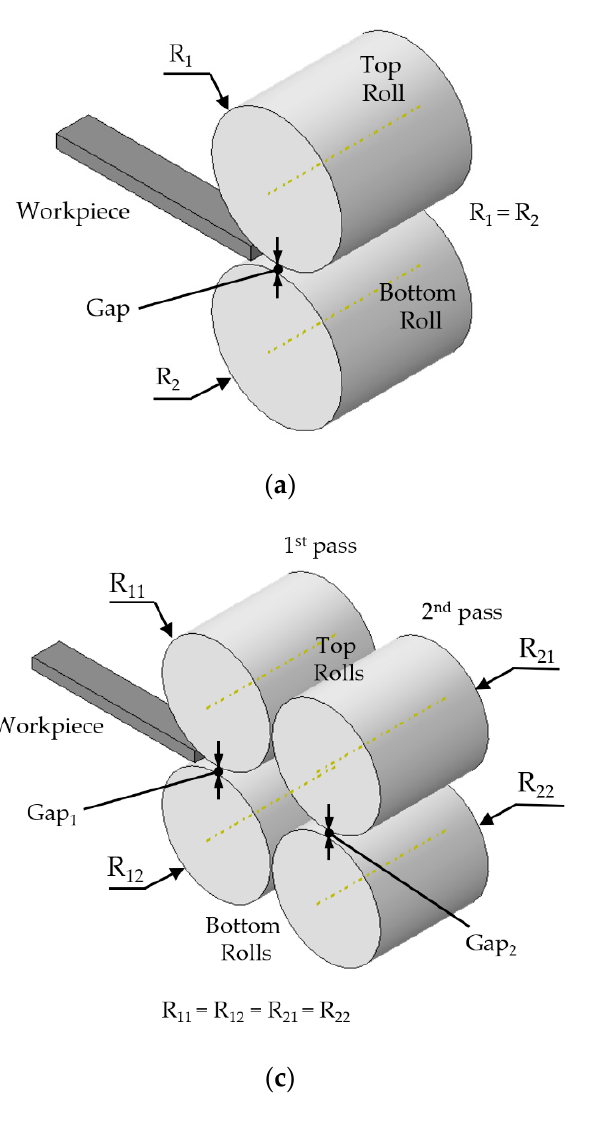
Figure 1. Geometrical models representation. ( a ) A single-pass rolling process; ( b ) A single-pass ASR process due to rolls’ diameters mismatch; ( c ) A two-pass rolling process; ( d ) Workpiece measurements.